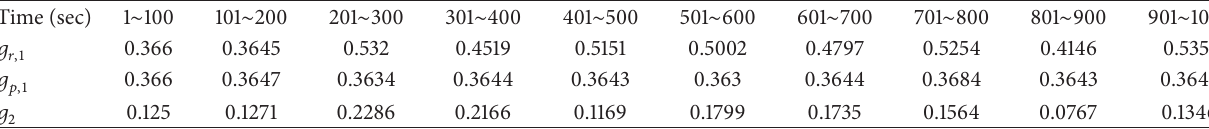
Table 6: Estimated gain parameters for PSO based adaptive 𝛼 - 𝛽 - 𝛾 filter.